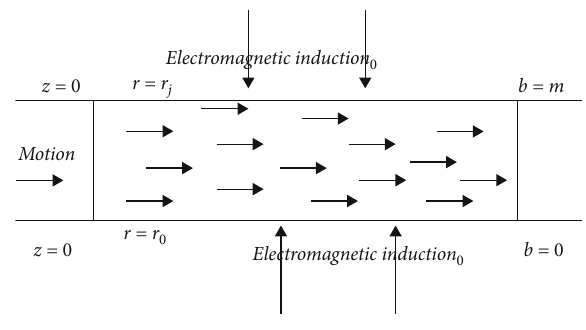
Figure 1: Described the